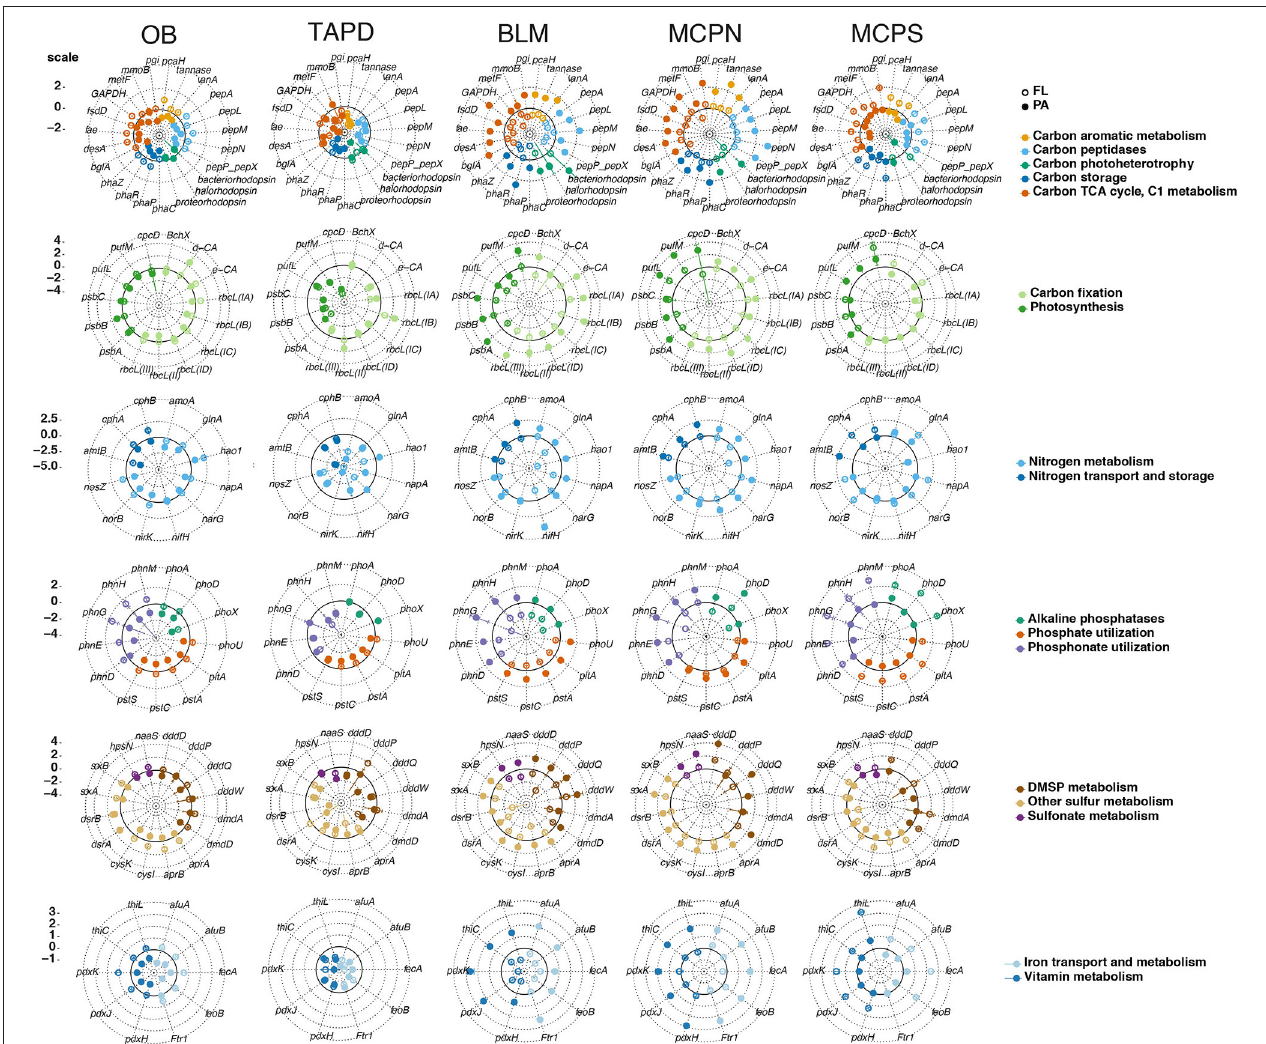
FIGURE 3 | Expression ratios (transcripts gene copy − 1 ) of 89 biogeochemically-relevant genes for two microbial size fractions at five river stations normalized to the median value for each gene. Genes are grouped according to broad functional categories and colored based on subcategories. Circle fill indicates microenvironment (free-living, open; particle-associated, closed). The scale bar at the left indicates the log 2 deviation from the median value for all plots on that row. The ring drawn with a bold line in each plot indicates the median value (where log 2 = 0).